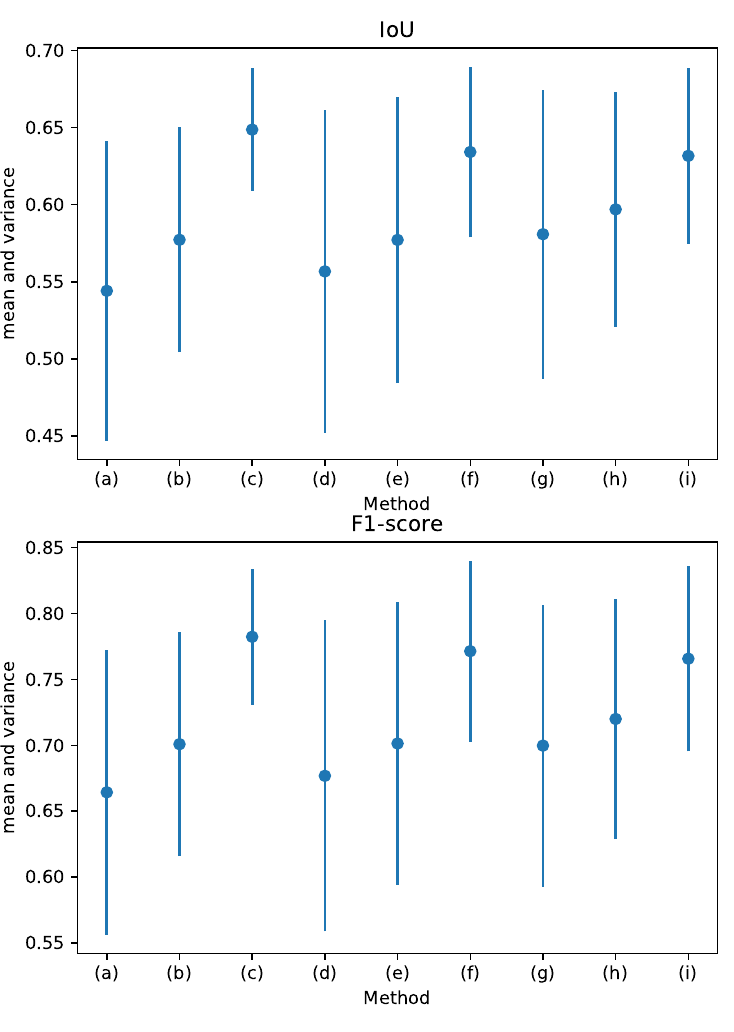
Figure 8. (a): DeeplabV3plus, (b): DeeplabV3plus+, (c): DeeplabV3plus++, (d): DLinkNet34, (e): DLinkNet34+, (f): DLinkNet34++, (g): LinkNet34, (h): LinkNet34+, (i):